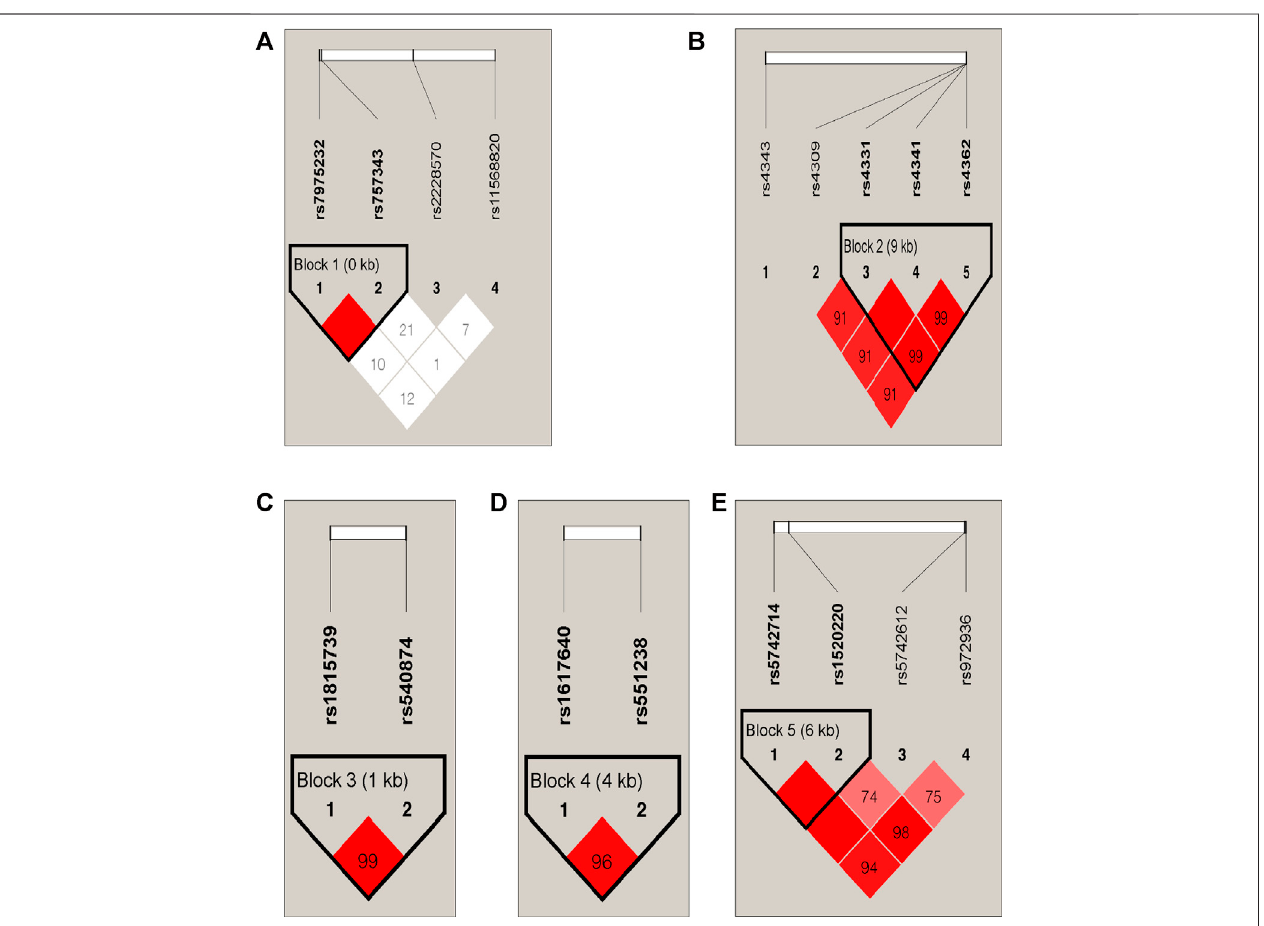
FIGURE 2 | LD Plot. (A) The block1 containing two SNPs was constructed in the VDR gene. (B) The block2 containing three SNPs was constructed in the ACE gene. (C) Theblock3 containingtwo SNPs wasconstructed in the ACTN3 gene. (D) Theblock4 containingtwo SNPs wasconstructed in the EPO gene. (E) Theblock5 containing two SNPs was constructed in the IGF1